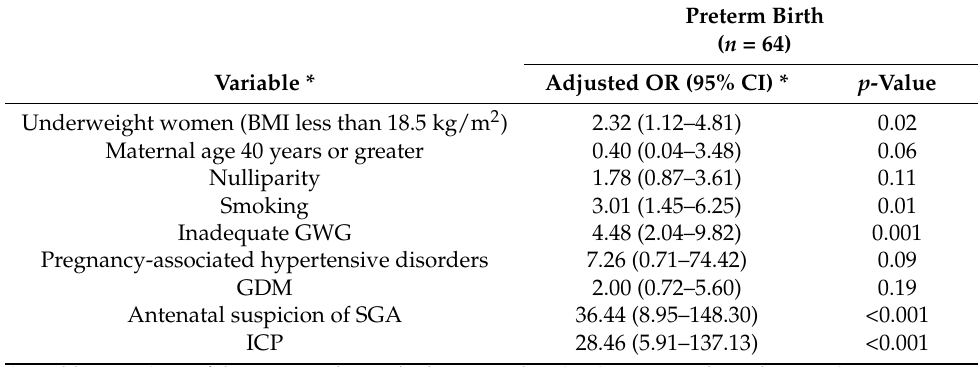
Table 3. Multivariate analysis of preterm birth among underweight and normal prepregnancy BMI women.